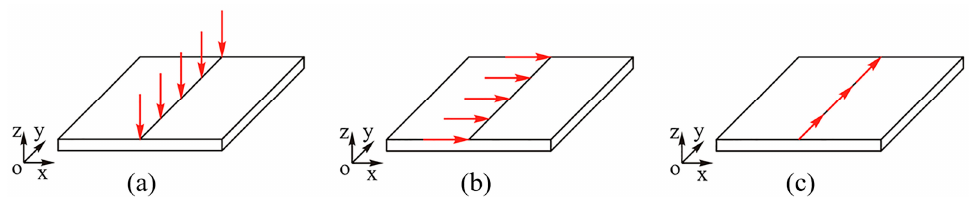
Figure 1. The typical line source loading types: ( a ) Normal loading; ( b ) Tangential shear loading; ( c ) Anti-plane shear loading.